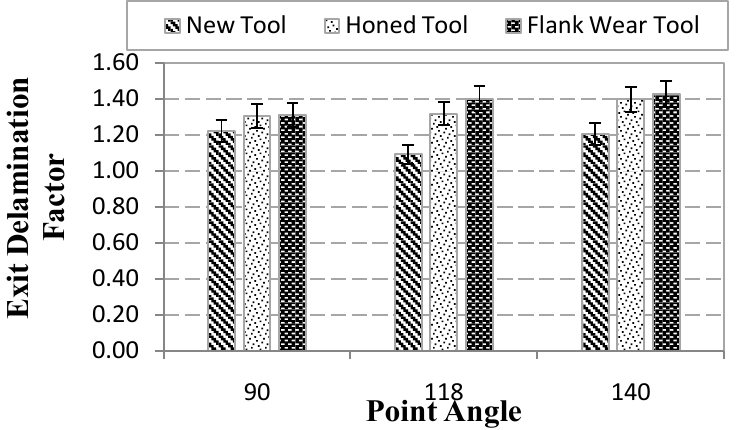
Figure 8. Maximum delamination at the hole exit (measurement variations are indicated including error bars).